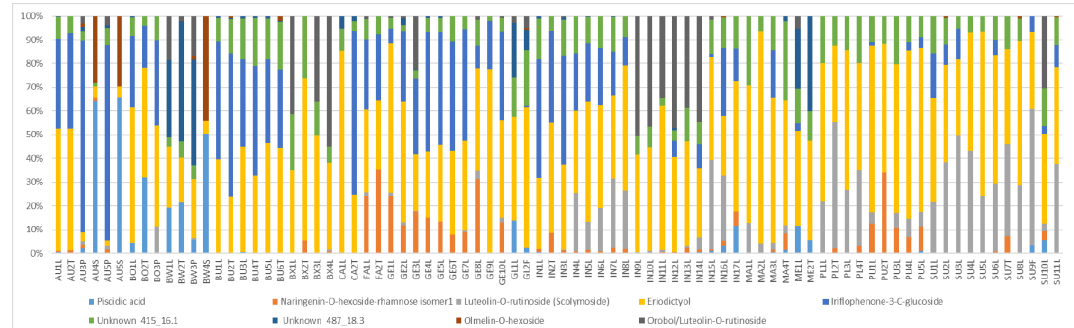
Figure 13. Composition of phenolic compounds relative to the total from the loading plots that caused